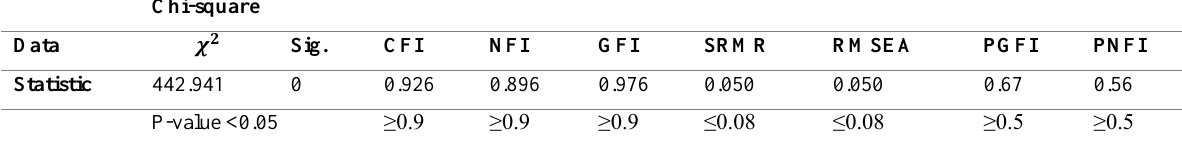
Table 8: Model fit